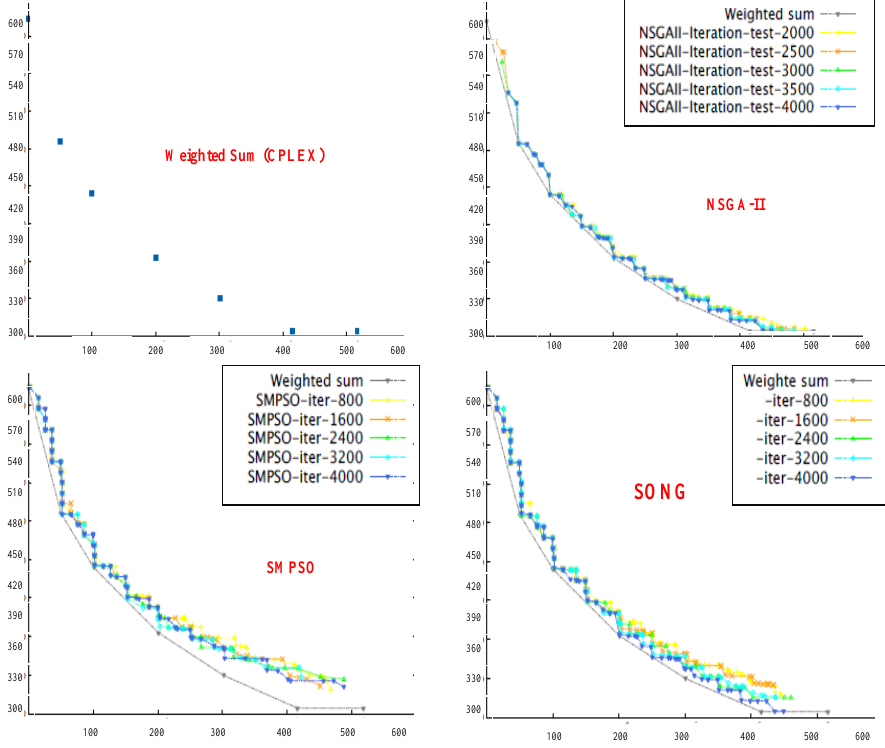
Figure 10. Solution frontiers for Π ( 10,30,5, ∞ )